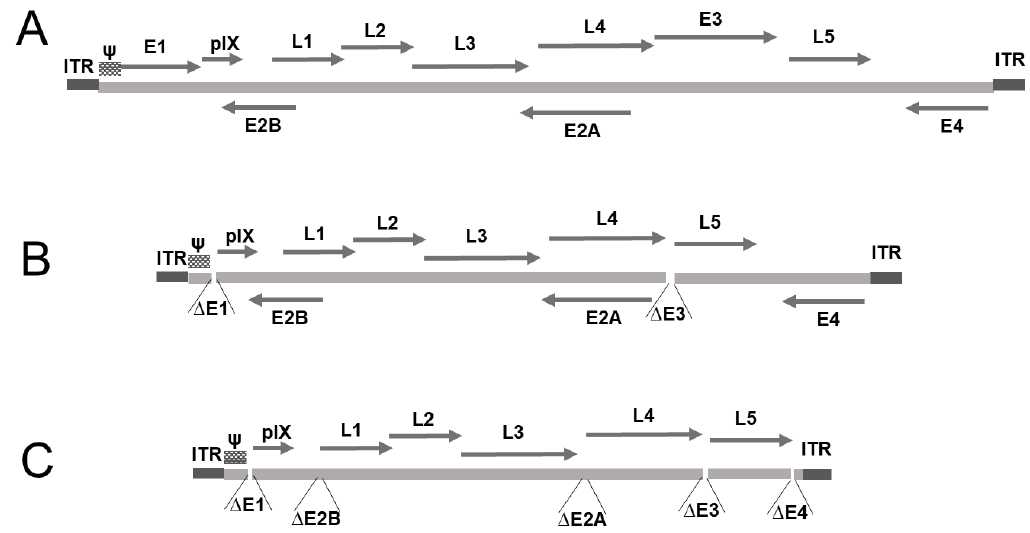
Figure 2. Adenovirus-based vectors. ( A ) A map of the human adenovirus type 5 (HAd5) genome. It consists of early genes (E1–E4) that suppress cell responses against the virus, and are responsible for the replication and regulation of viral transcription. The late genes (L1–L5) encode the structural proteins of the virus. ( B ) A first-generation adenovirus-based vector (8-kb packaging capacity) in which the E1 and E3 genes have been deleted. ( C ) A second-generation vector in which the E2 and E4 genes have been deleted to increase packaging capacity (14-kb packaging capacity). For packaging, the plasmid harboring the transgene is transfected with a helper plasmid for the expression of viral genes E1, E2, and E4.